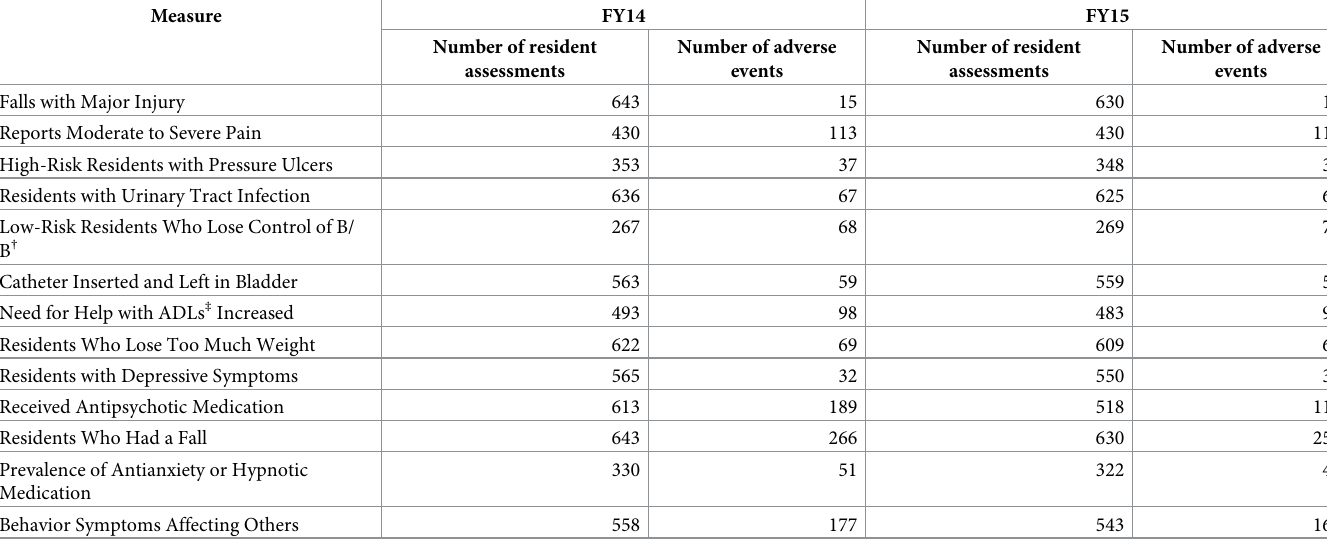
Table 1. CLC mean values of quality monitor resident eligibility and adverse